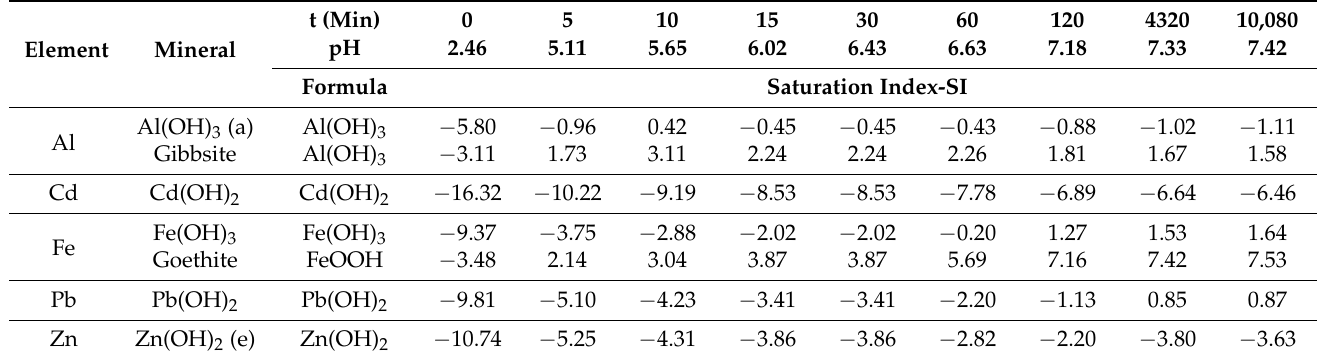
Table 7. Results of the PHREEQC software simulation in the case with KOST fly ash neutralization